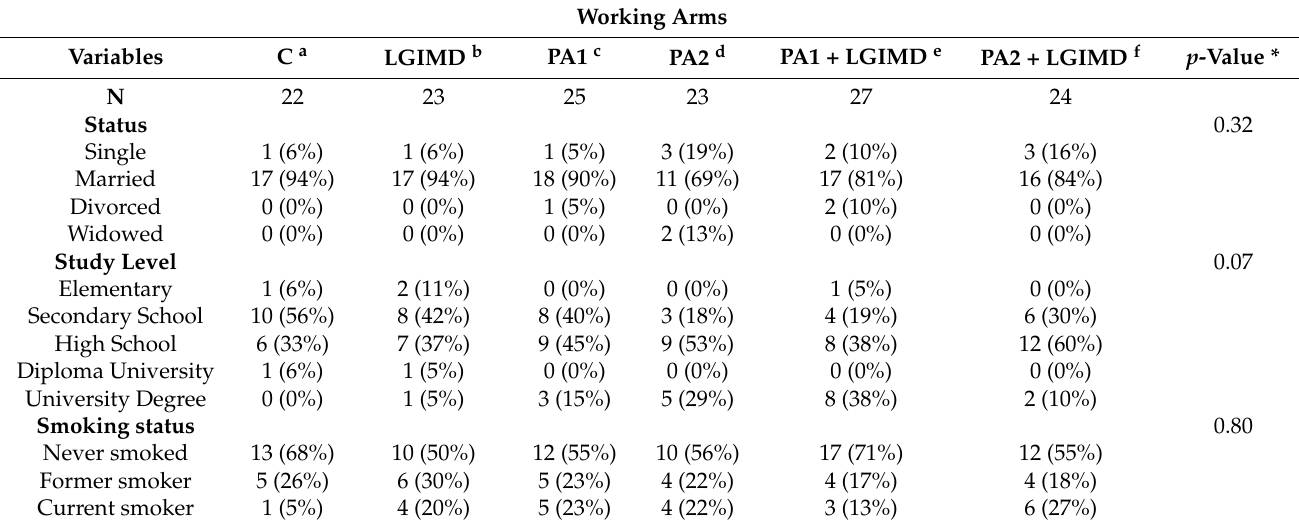
Table 2. Additional Characteristics of Participants by Intervention Arm and Time. NutriAtt Trial, Castellana Grotte,